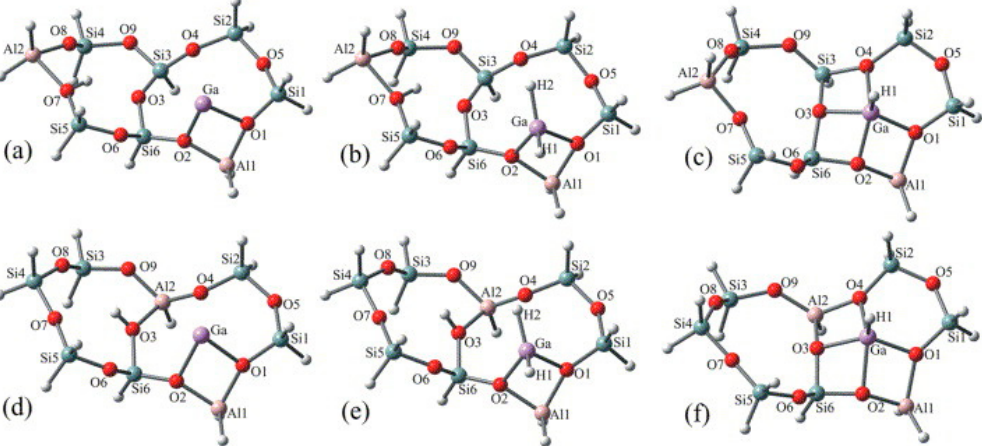
Figure 7. Optimized structures of potential Ga species in Ga-modified ZSM-5. ( a ) Ga + Z d , ( b ) [GaH 2 ] + Z d , ( c ) [GaH] 2+ Z d , ( d ) Ga + Z s , ( e ) [GaH 2 ] + Z s , and ( f ) [GaH] 2+ Z s clusters. Reprinted with permission from ref [113]. Copyright 2006 Elsevier.